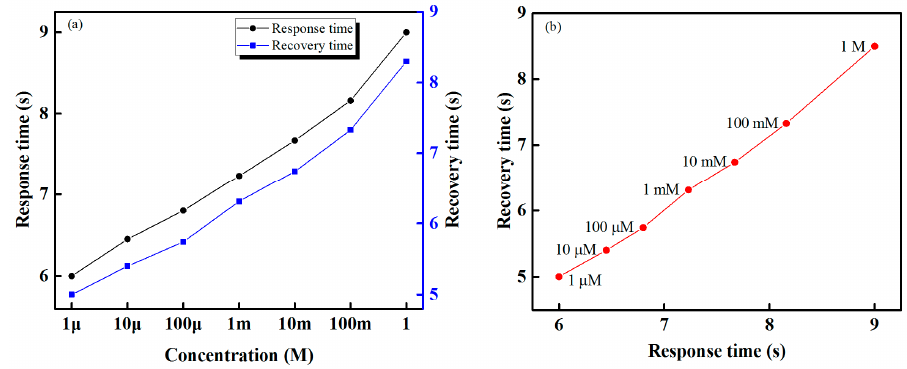
Figure 13. Sensing performance of the designed IDC electronic tongue for different concentrations of HCl: ( a ) response and recovery times and ( b ) response times versus recovery times.